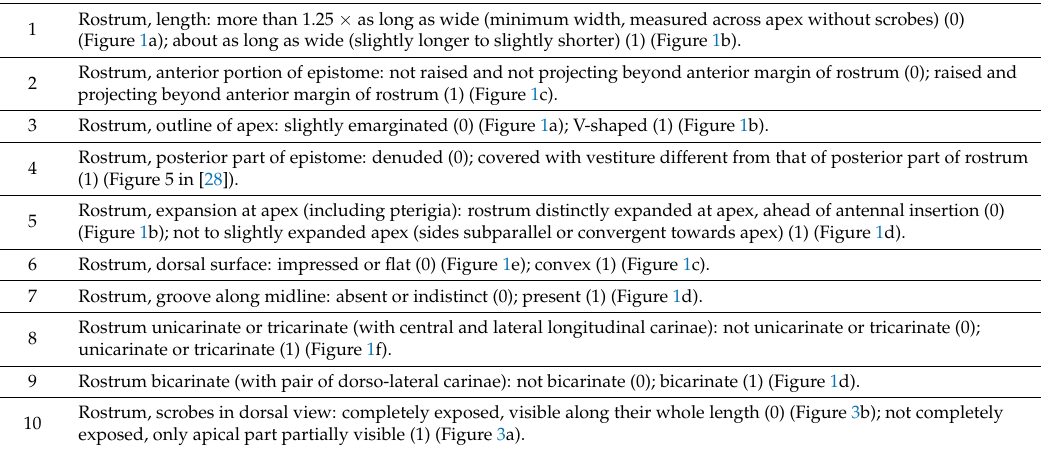
Table 3. List of the 70 morphological characters, character states and